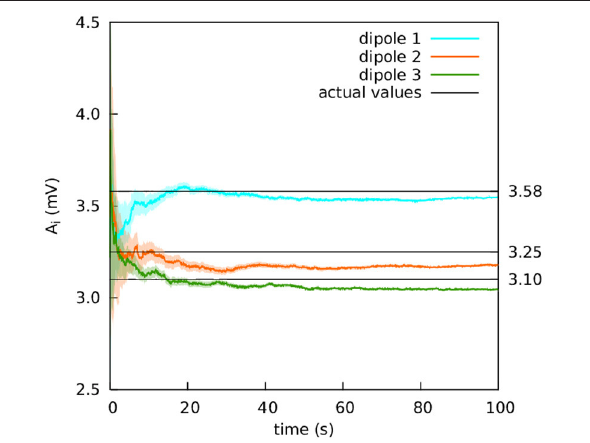
FIGURE 9 | Extracranial fit with parameters close together in value. The estimations of the amplitude of the EPSPs of the three cortical columns are shown after averaging over 50 realisations (solid lines); the shadowed areas indicate the standard deviation. The actual values of the amplitudes of the EPSPs are A 1 3.58 mV, A 2 3.25 mV, and A 3 3.10 mV; the rest of the = = = parameters were set to standard values ( Table 1 ). The external input p ( t ) for the three cortical columns had p 0 200 s − 1 and ǫ 100 s − 1 . The coupling = = constant was set to k 5. The Gaussian noise in the extracranial = measurements has standard deviation 100 mV. The estimation of the parameters is fairly